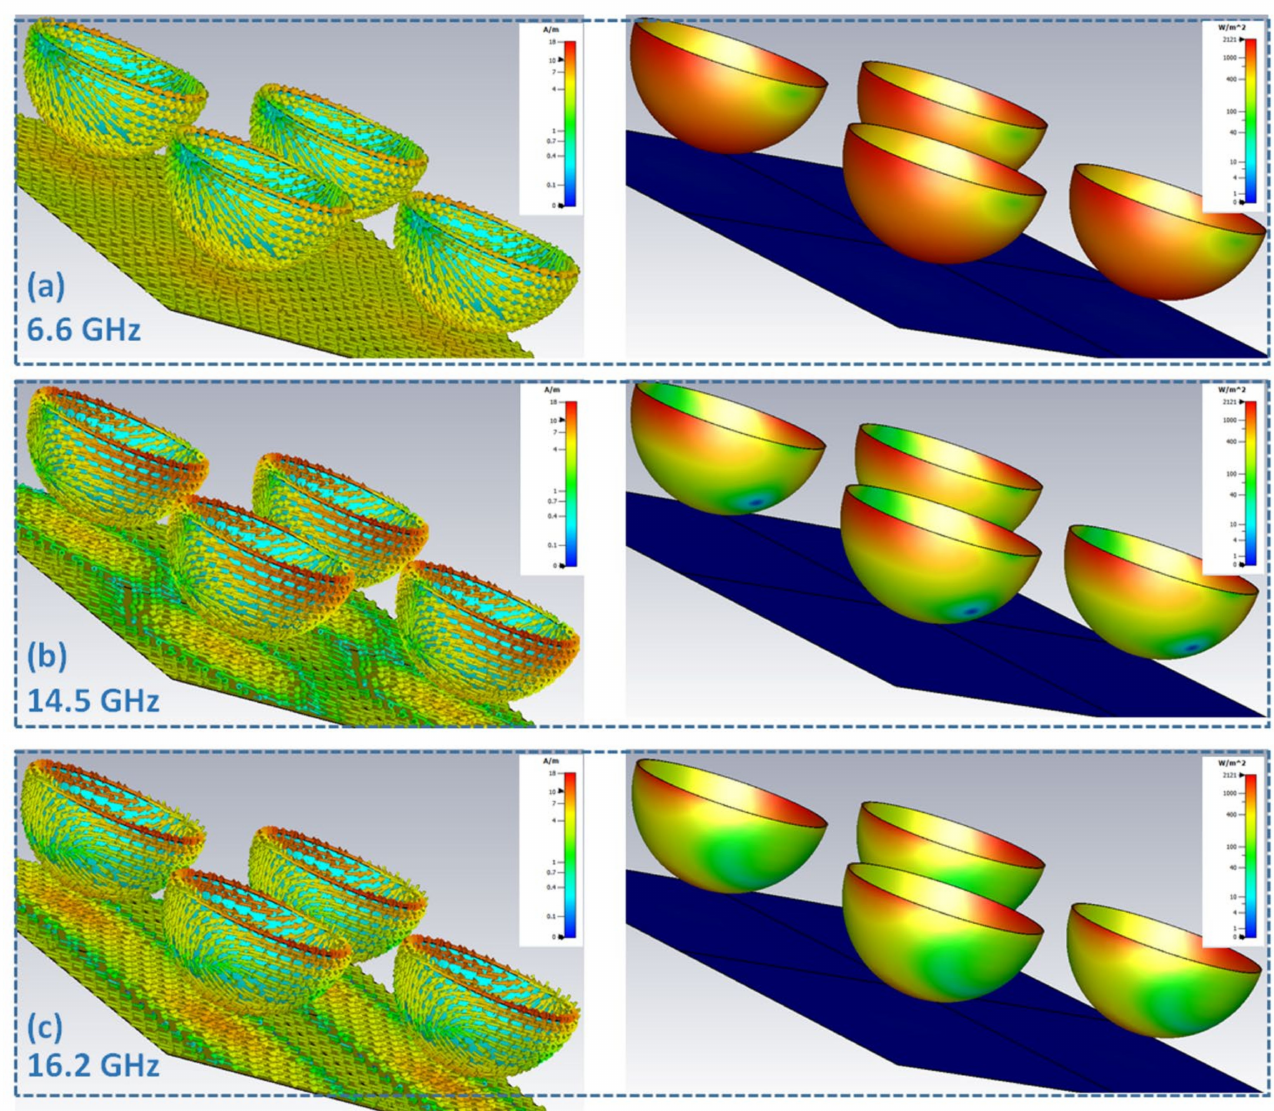
Figure 3. Distribution of the induced surface currents ( left ) and surface loss density ( right ) for ( a ) 6.6, ( b ) 14.5, and ( c ) 16.2 GHz, in the case of CU